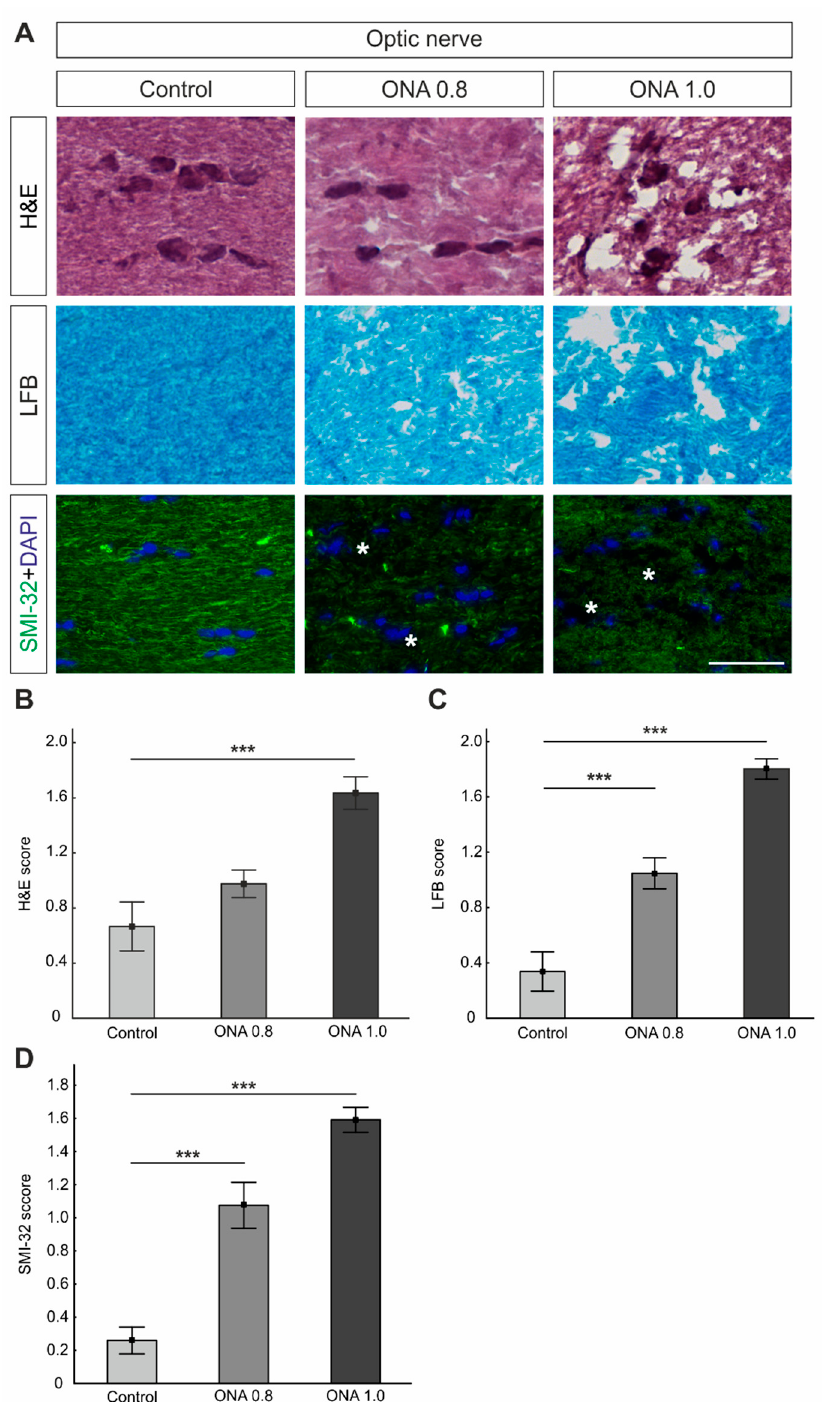
Figure 5. Optic nerve degeneration. ( A ) Optic nerves were stained with hematoxylin and eosin (H&E) and luxol fast blue (LFB). Additionally, neurofilaments were labeled with an antibody against anti-SMI-32 (green). Cell nuclei were marked with DAPI (blue). Asterisks point towards disrupted filaments. ( B ) The ONA 0.8 group and control group had a similar H&E score ( p > 0.05), while a significantly higher score was noted in ONA 1.0 optic nerves ( p < 0.001). ( C ) The LFB staining revealed an interruption of myelin sheaths in both ONA immunized groups (both: p < 0.001). ( D ) Additionally, we noted a higher SMI-32 score in the ONA 0.8 as well as in the ONA 1.0 optic nerves ( p < 0.001). Values are mean ± SEM. Scale bar: 20 µm. *** p < 0.001.